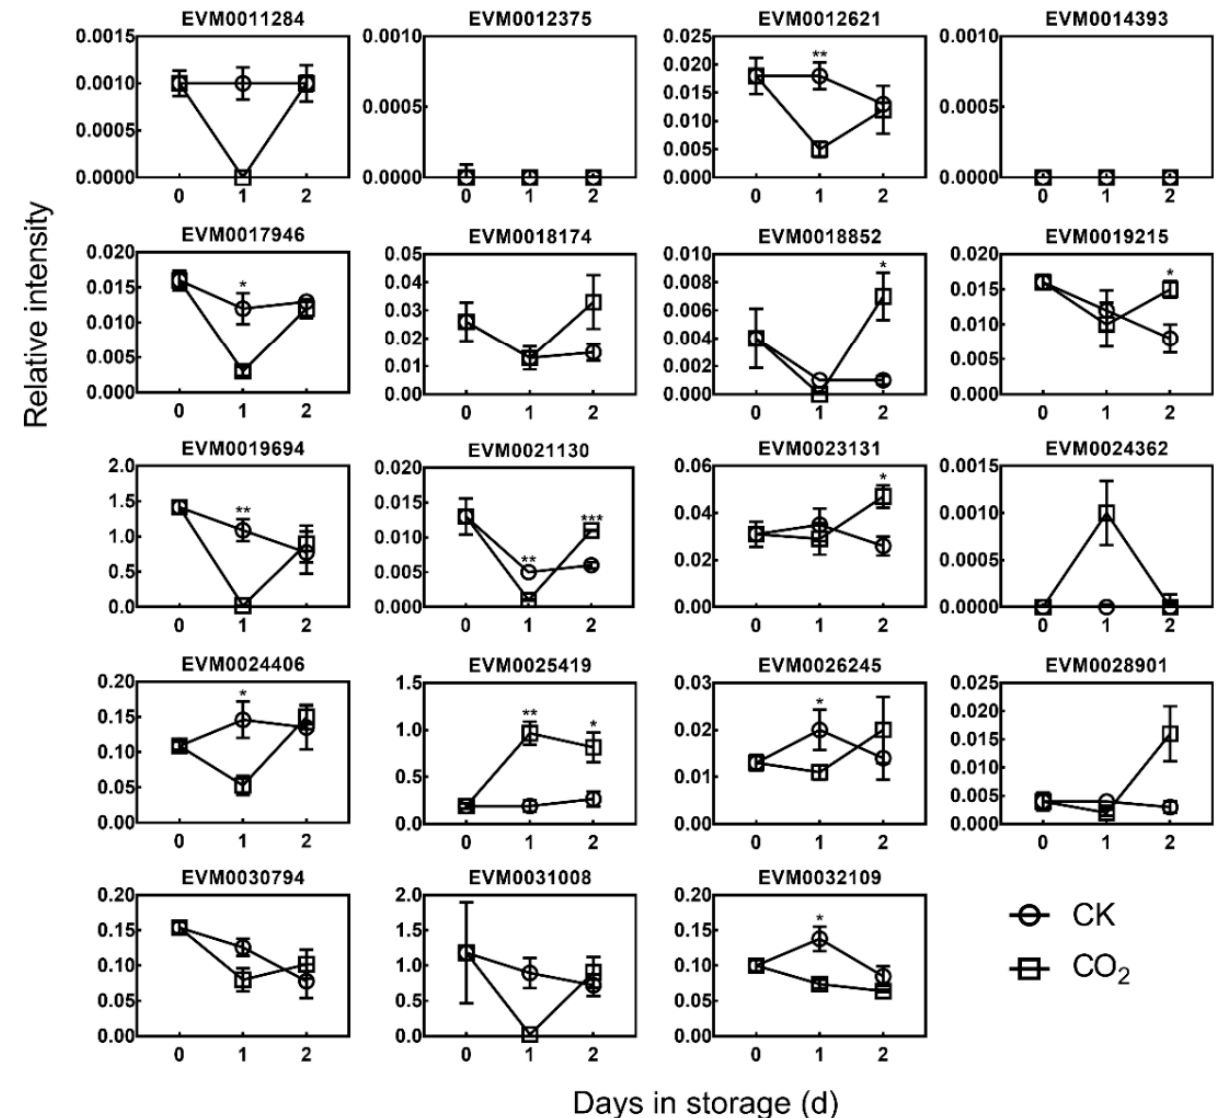
Figure 3. Expression of DkDofs in response to high CO 2 treatment in ‘Gongcheng-shuishi’ fruit. EVM0031008 , EVM0019694 , EVM0011284 , EVM0025419 , EVM0003933 , EVM0024406 , and EVM0012621 were designated as DkDof1-7 . DkACT was used as internal control. Error bars repre- sent standard errors for three replicates (*, p < 0.05; **, p < 0.01; ***, p < 0.001).